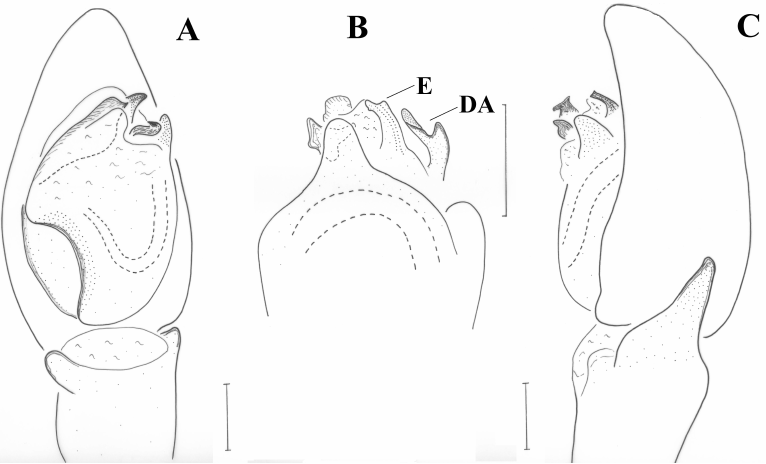
Figure 10. Haplodrassus caspius , male pedipalp (FC: 17086). ( A ) Ventral view, ( B ) dorsal view, ( C ) retro- lateral view. E: embolus, DA: dorsal apophysis.